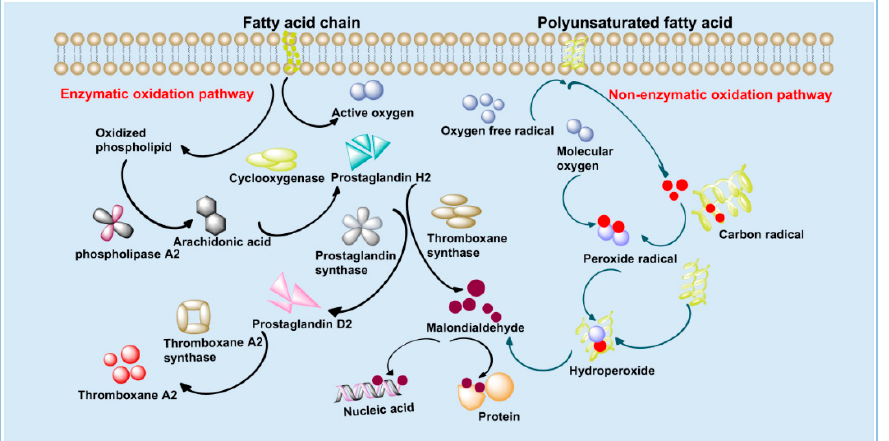
Figure 7. The generation route of MDA.